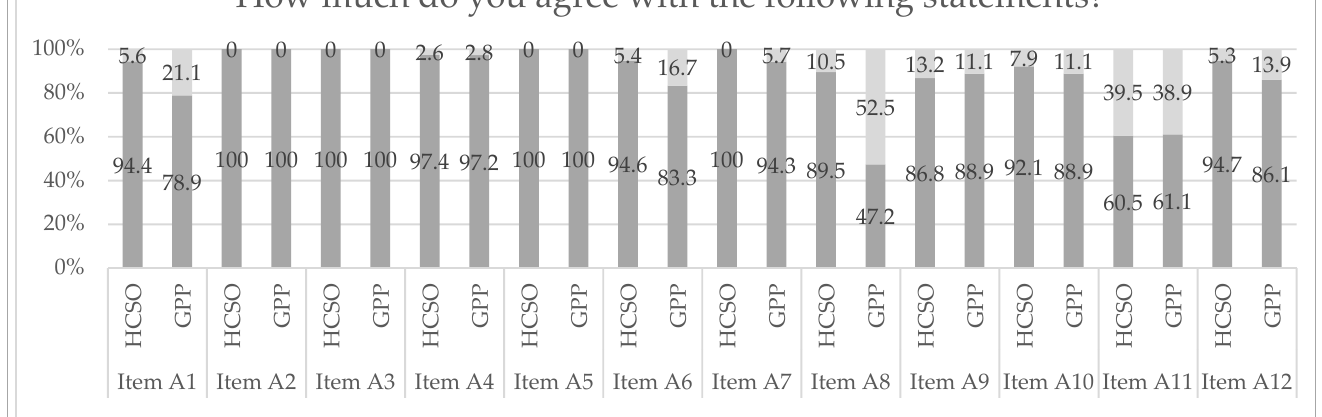
Figure 4. Health professionals’ attitudes towards health literacy in primary care. Legend: Item A1 = Health literacy is relevant for organizations such as GPs, HCSOs and hospitals and not a trendy